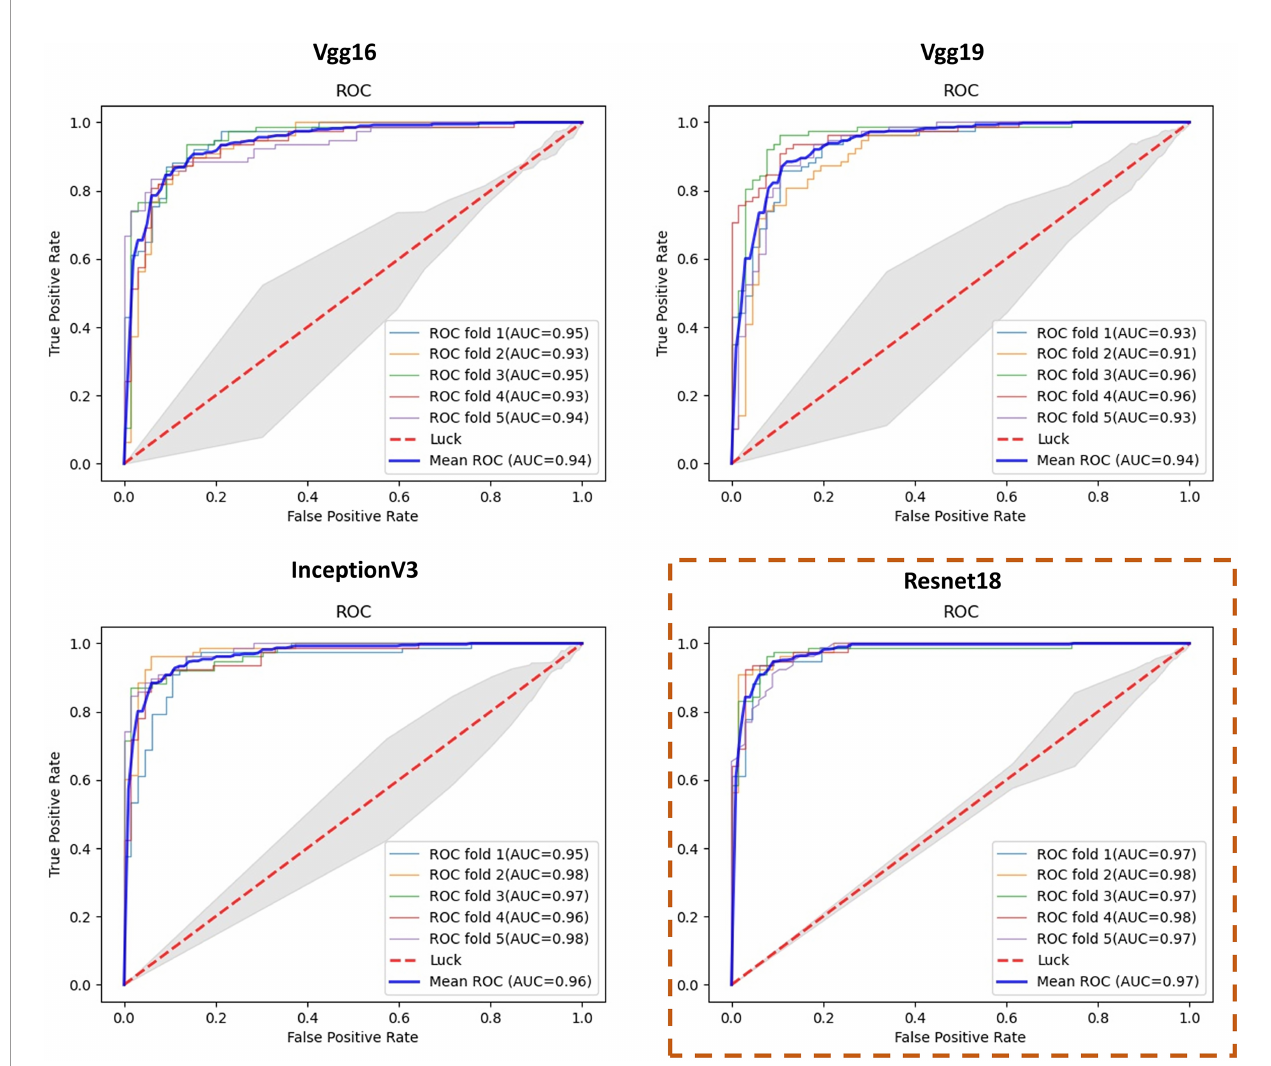
FIGURE 4 | ROC curves of classi fi cation results using different feature extraction